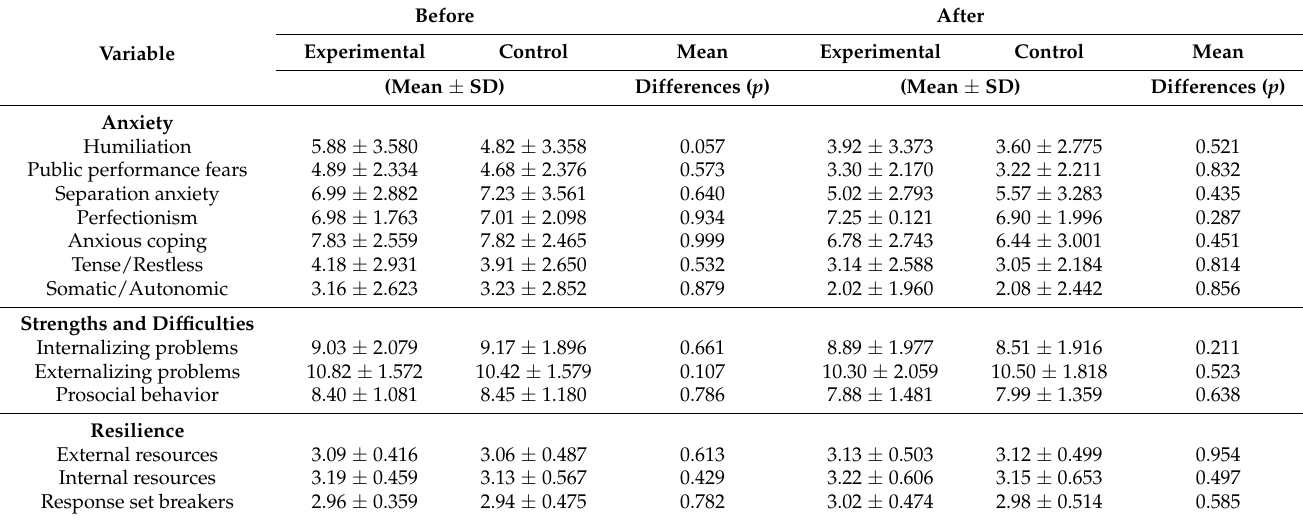
Table 1. Descriptive results of the repeated measures.